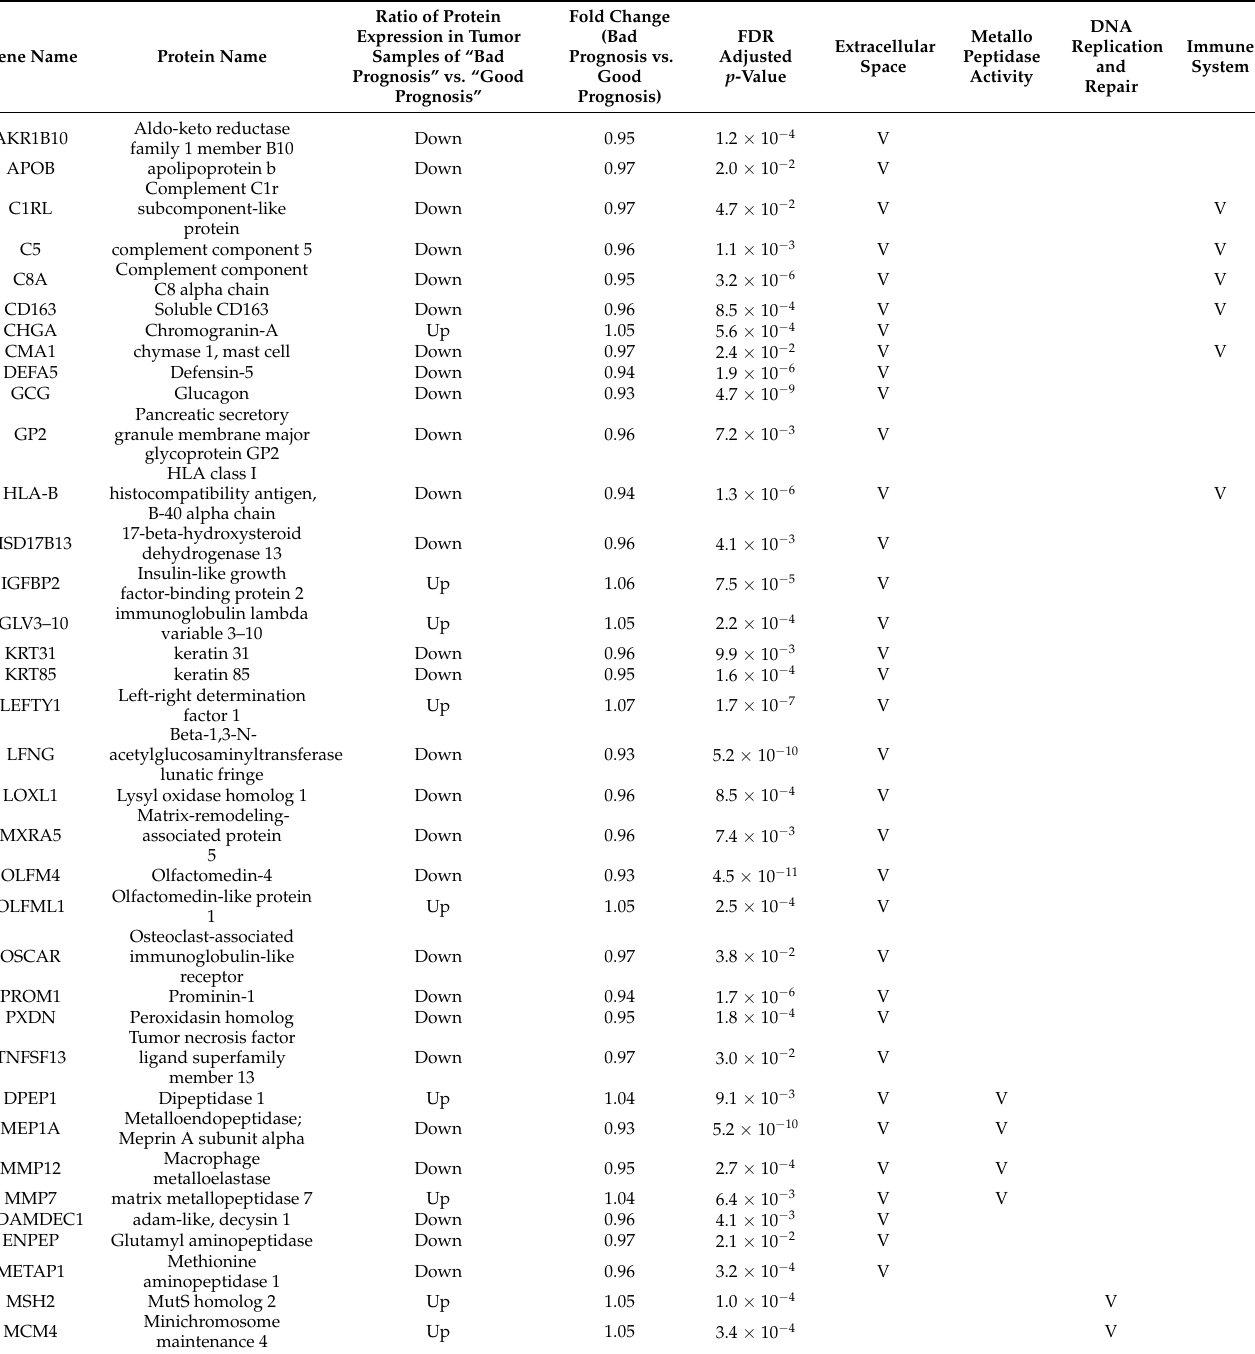
Table 2. Significant proteins according to proteomic analysis and their related pathways of expression—A normal test was used on the fold change (presented on a log scale) to compare the expression of each protein between the “good prognosis” and the “poor prognosis” groups. p -values across all proteins were adjusted to control the false discovery rate